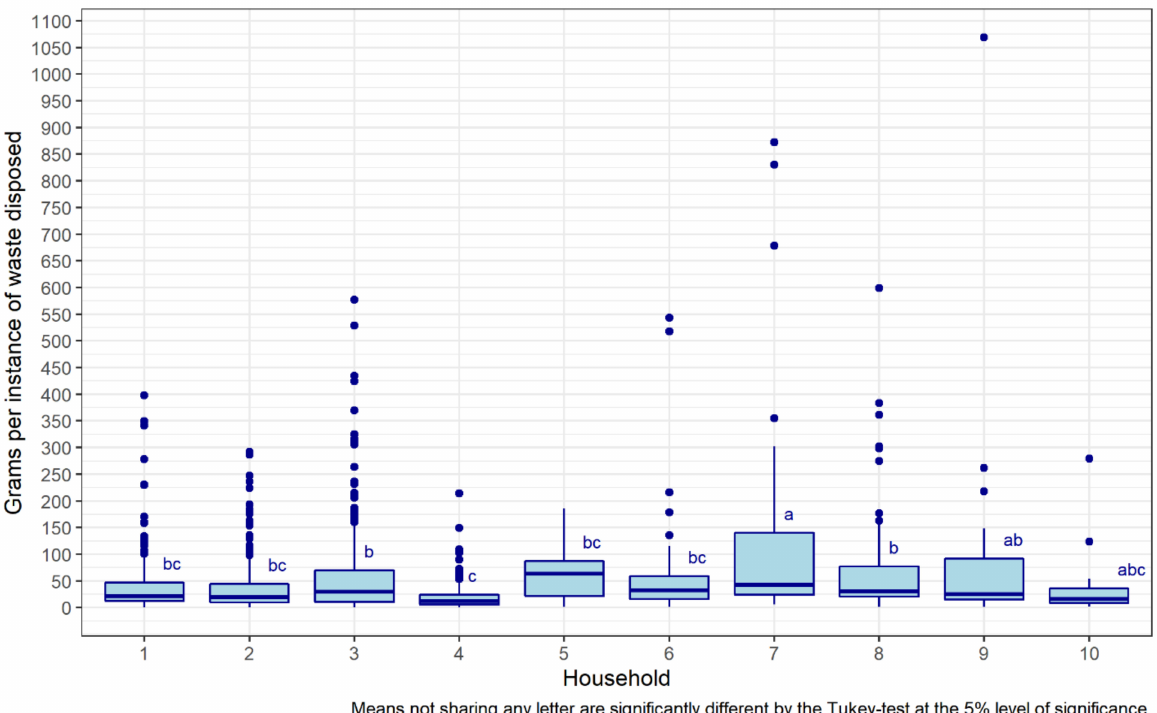
Figure 7. Grams per instance of waste disposed between